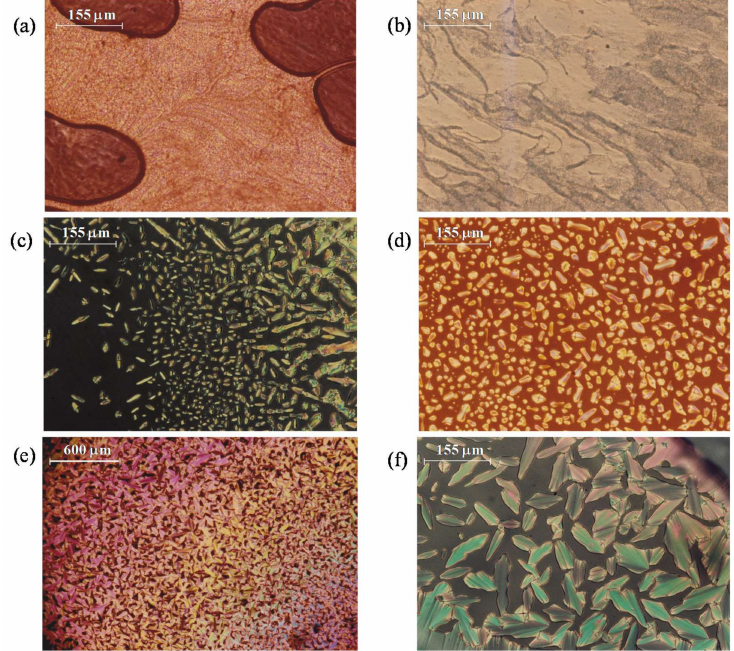
Figure 6. Micrographs with crossed polarizers showing SmA mesophases of compounds: BF 4 -4,12 (9) at 173 ◦ C on heating ( a ); PTS-8,8 (16) at 193 ◦ C on heating ( b ); ReO 4 -4,12 (13) at 227 ◦ C on cooling ( c ); BF 4 -12,12 (8) at 148 ◦ C on cooling ( d ); Cl-4,4 (1) at 191 ◦ C on cooling ( e ); and ReO 4 -4,12 (13) at 208 ◦ C on cooling ( f